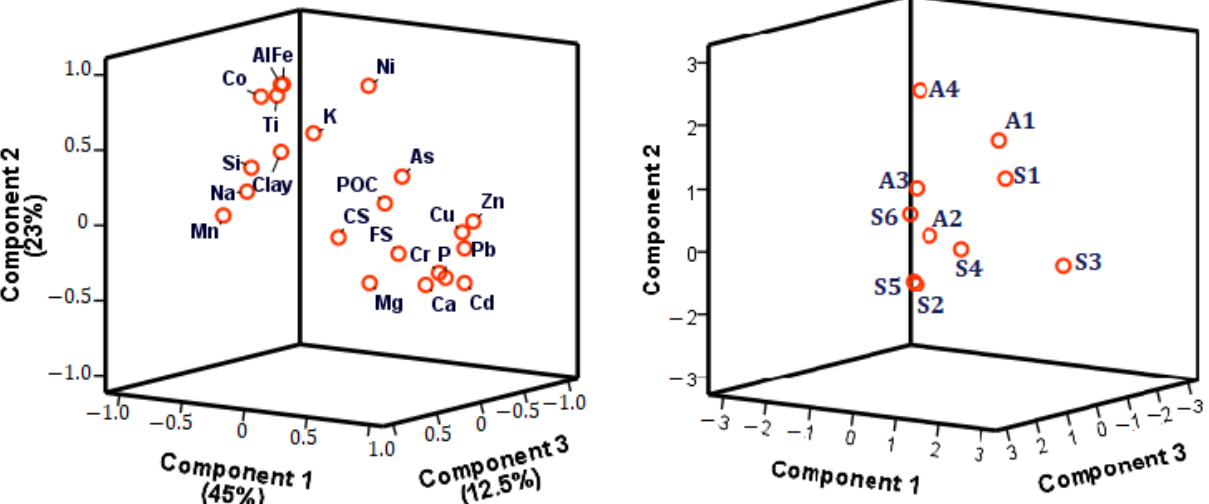
Figure 4. Three-dimensional representation of PCA for the three main components, considering trace metals and major elements, clay, fine silt (FS), coarse silt (CS), and POC content in bottom sediments of the Sebou basin.